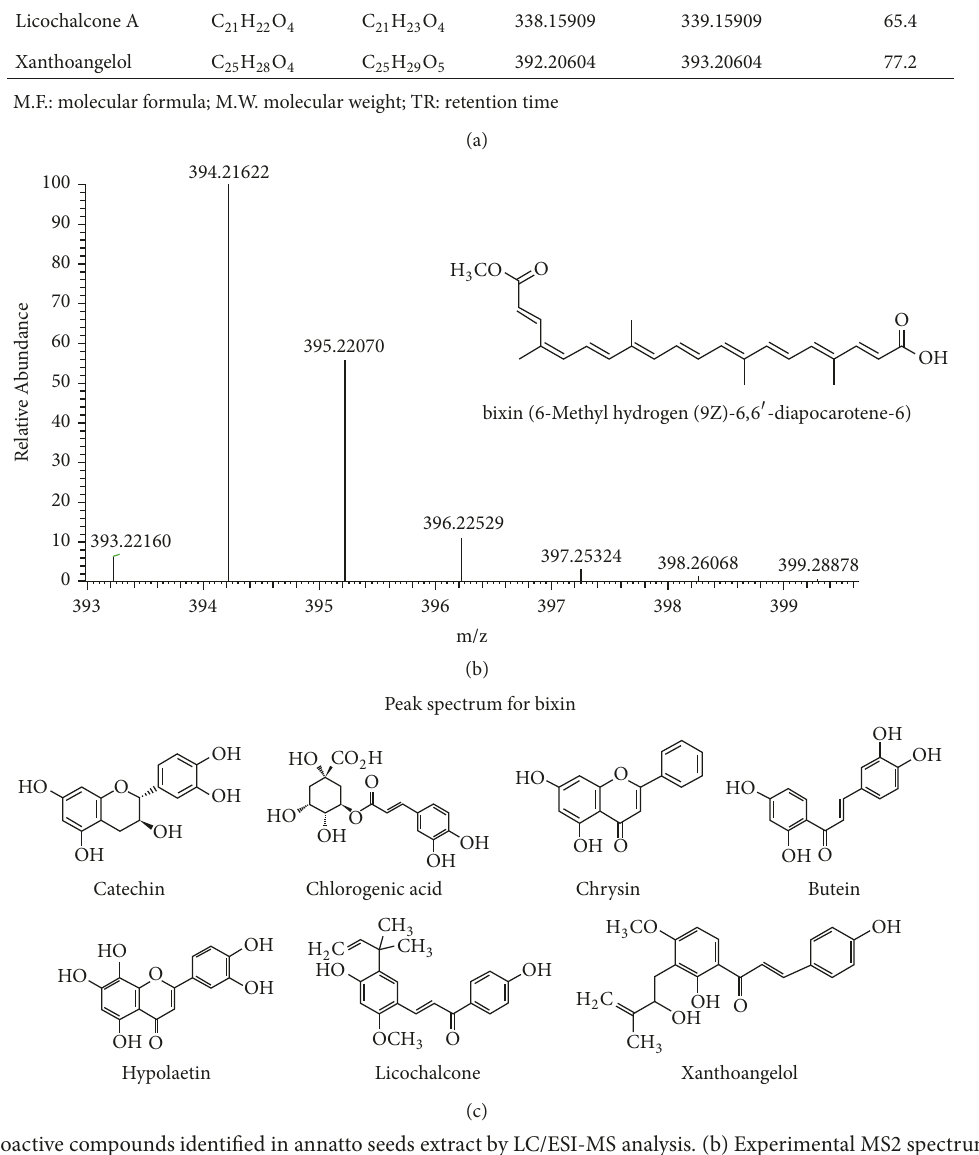
Figure 2: (a) Bioactive compounds identified in annatto seeds extract by LC/ESI-MS analysis. (b) Experimental MS2 spectrum of the ion at m/z 394.22169 with the predicted structures of the ion at m/z 395.22070 arising from bixin (6-Methyl hydrogen (9Z)-6,6 󸀠 -diapocarotene-6). (c) Structures of polyphenol compounds identified from the annatto seeds